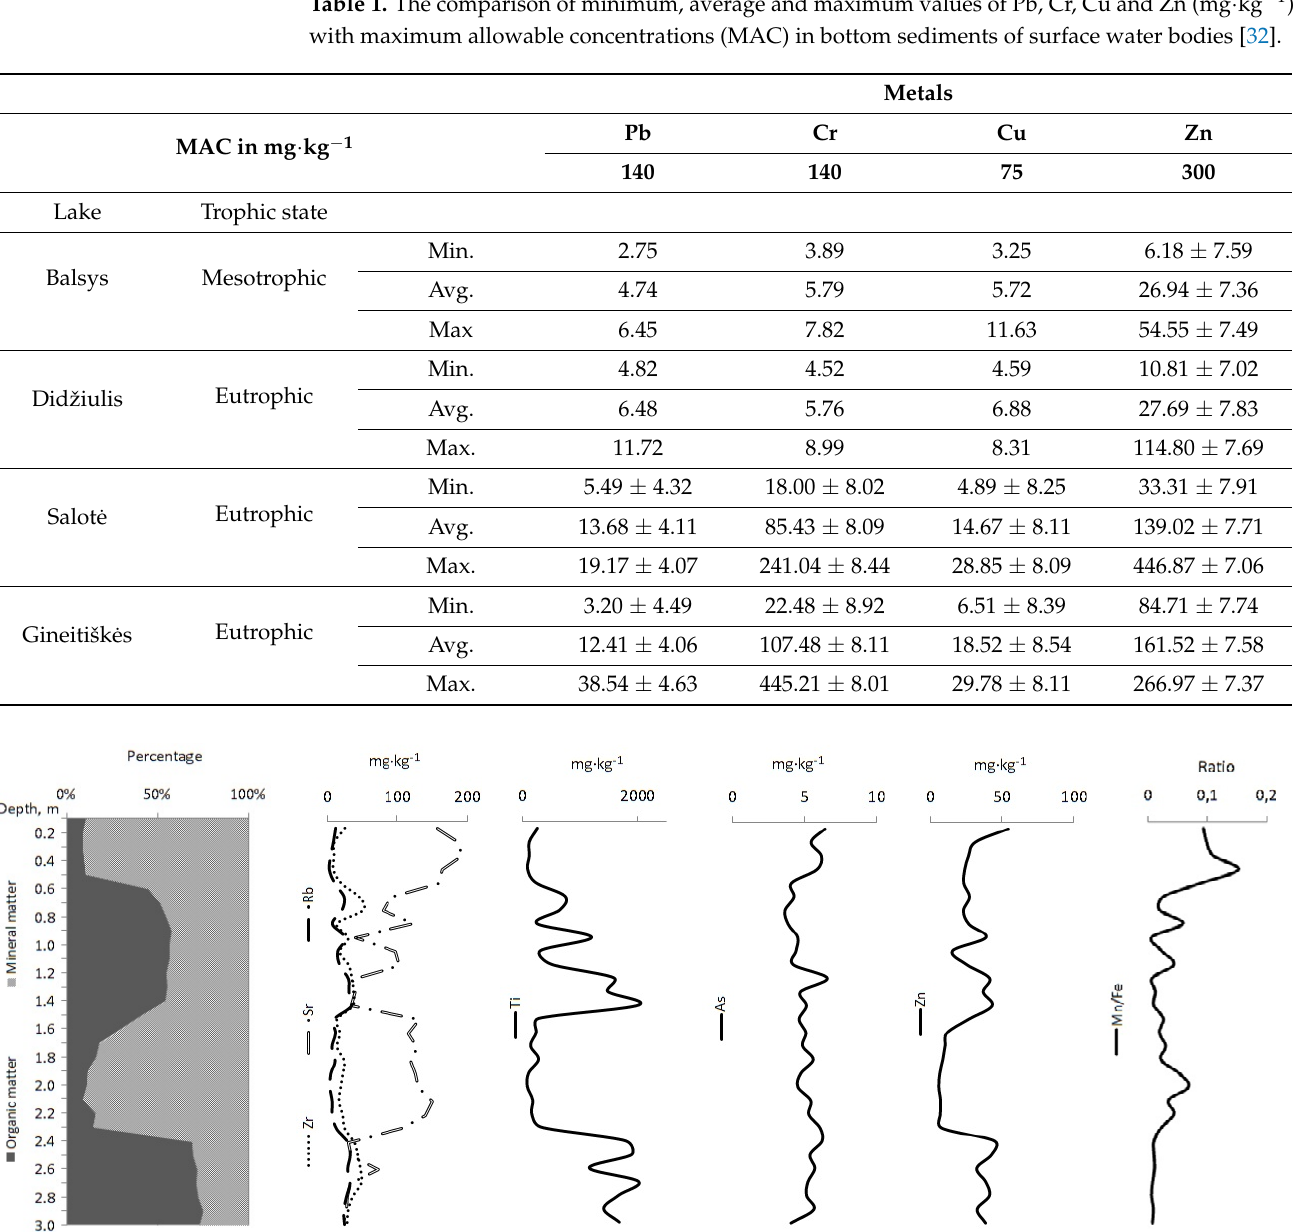
Figure 2. Main sediment components and concentrations of heavy metals in sediments of Lake Balsys.